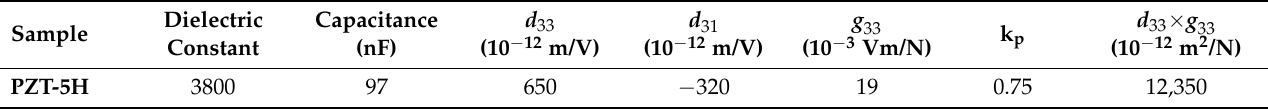
Figure 2. Finite element models of the piezoelectric energy harvesters with ( a ) × 1 layer, ( b ) × 2 layers, and ( c ) × 4 layers. Table 1. Characteristics of the piezoelectric materials used in the piezo-energy harvester.